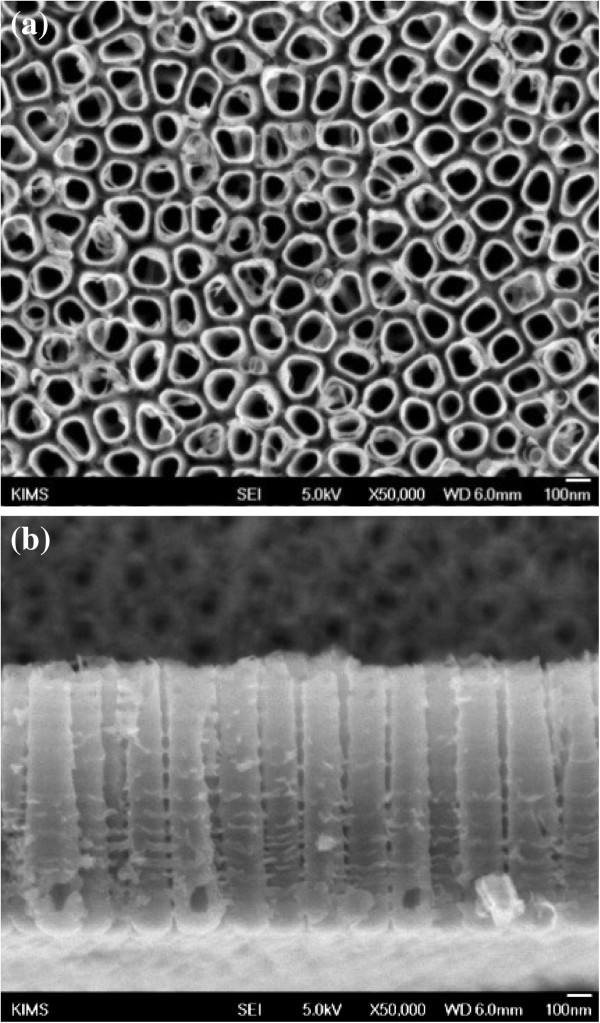
Typical (a) surface and (b) cross-sectional FE-SEM images of TiO2 nanotubes. The nanotubes were formed at an applied potential of 25 V for 2 h in 1 M H3PO4 + 0.3 M HF solution at 20°C.